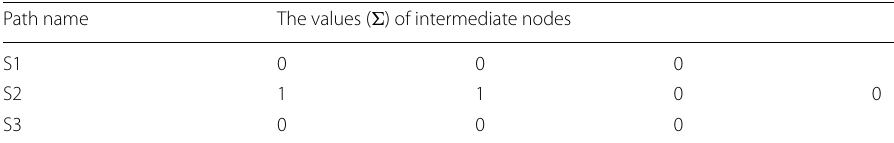
Table 1 Path memory routing table Path name